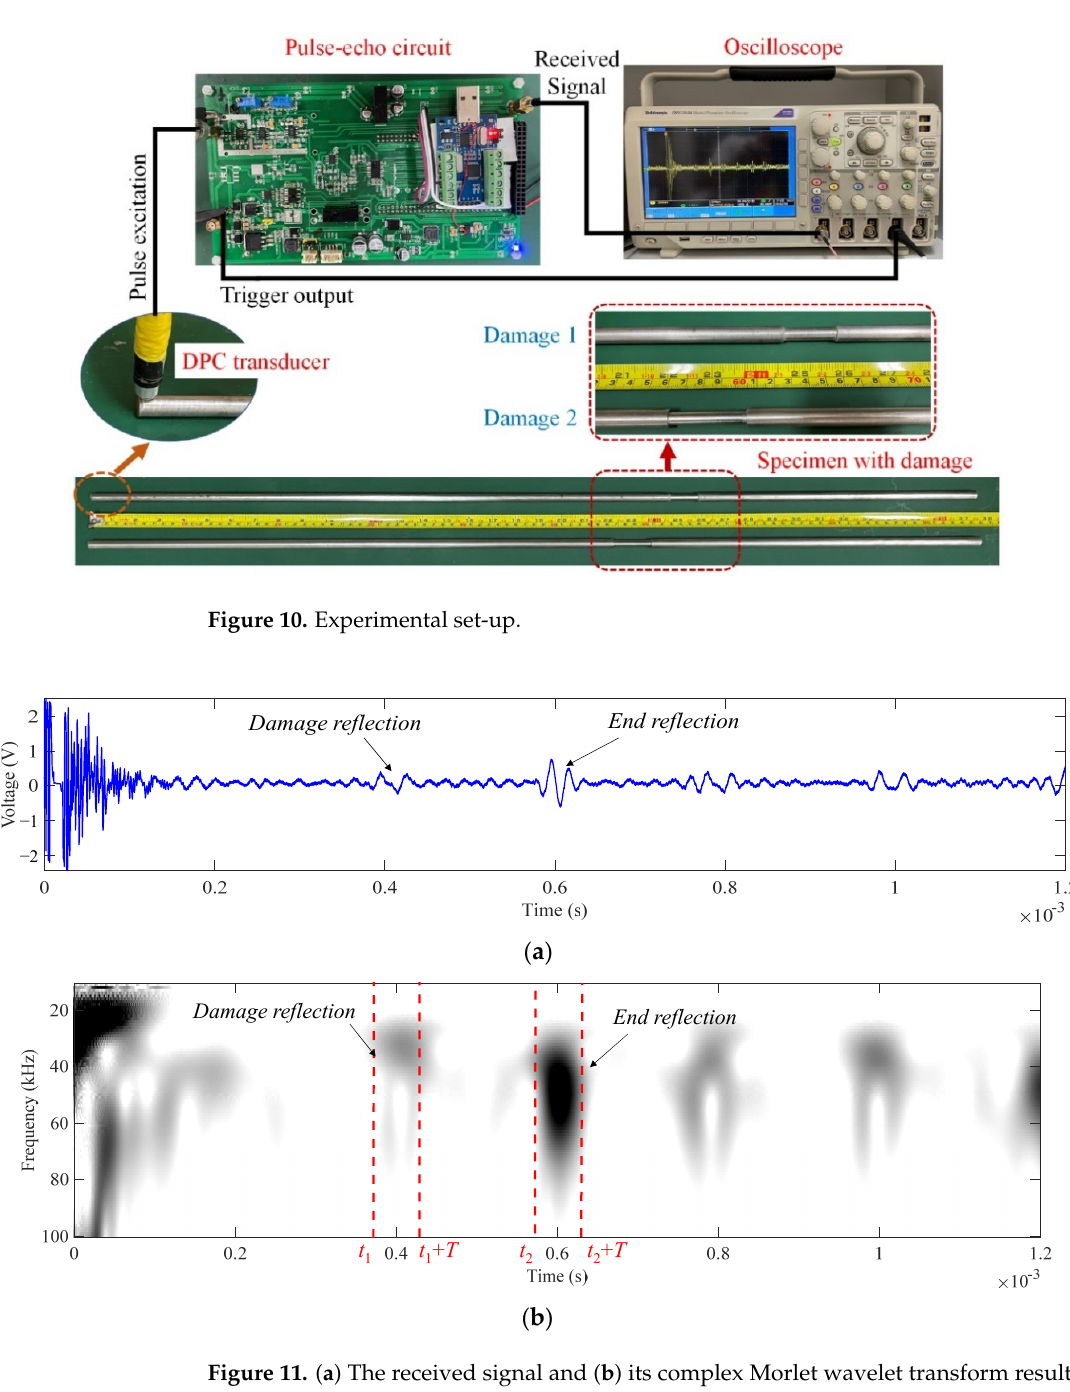
( b ) Figure 9. ( a ) Variation of the SRC with respect to the excitation frequency; ( b ) damage image for the 60 mm-wide and 1.05 mm-deep defect. 5. Experimental Validations The proposed damage quantification method is applied to quantify the size of the defects in two steel rods. The radius of the two rods at the intact segments is 5 mm and the total length is 960 mm. The experimental setup is illustrated in Figure 10. Instead of applying multiple excitations at different frequencies, a broadband excitation with a pulse signal is used. The frequency-dependent characteristics of the responses are extracted by post signal processing. A pulse-echo circuit developed by our lab is used to generate a 40 V pulse with a duration of 20 μ s. A DPC torsional-wave transducer (ACS ® S1802 manu- factured by Acoustic Control Systems, Saarbrücken, Germany) is applied to excite and capture the torsional waves in the rods with the nominal frequency at 50 kHz. The cap- tured waves are recorded by the oscilloscope with the sampling frequency at 50 MHz. 512 averages are performed to minimize the influence of noise. It should be highlighted the